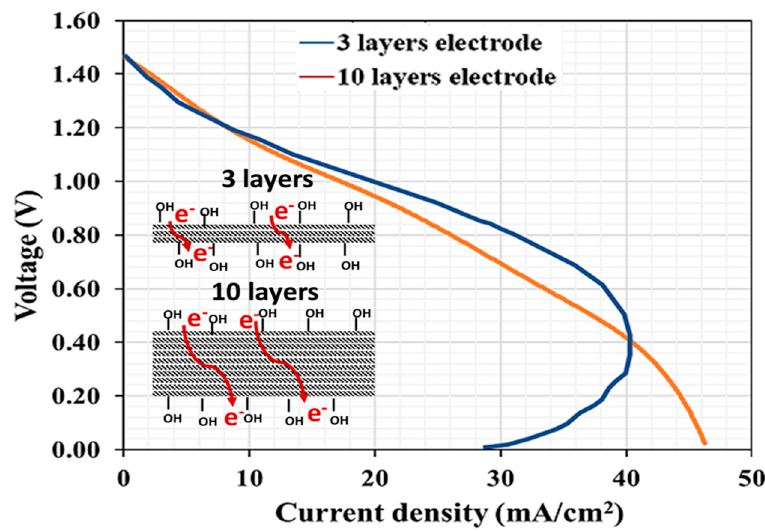
Figure 10. Polarization curves obtained from the discharging processes with three-layer and ten-layer electrodes.